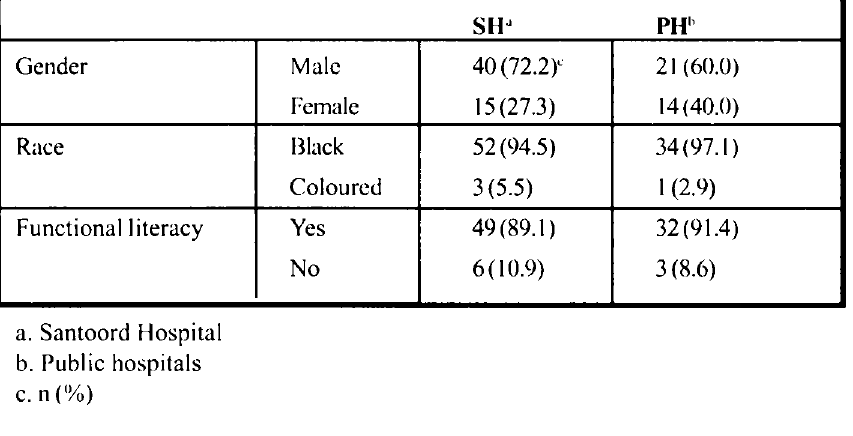
of public TB hospital patients.